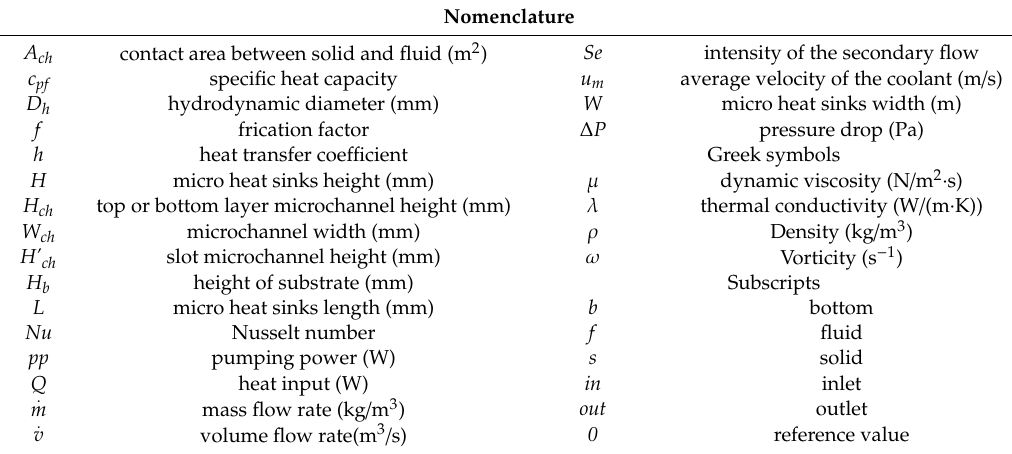
Table 1. Nomenclature used in the MCHS design and